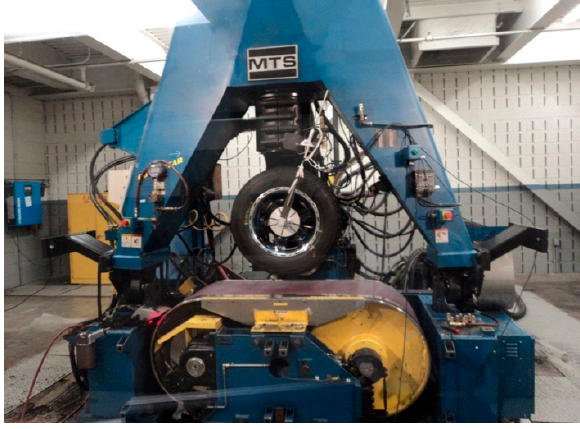
Figure 8. Flat-Trac® machine.